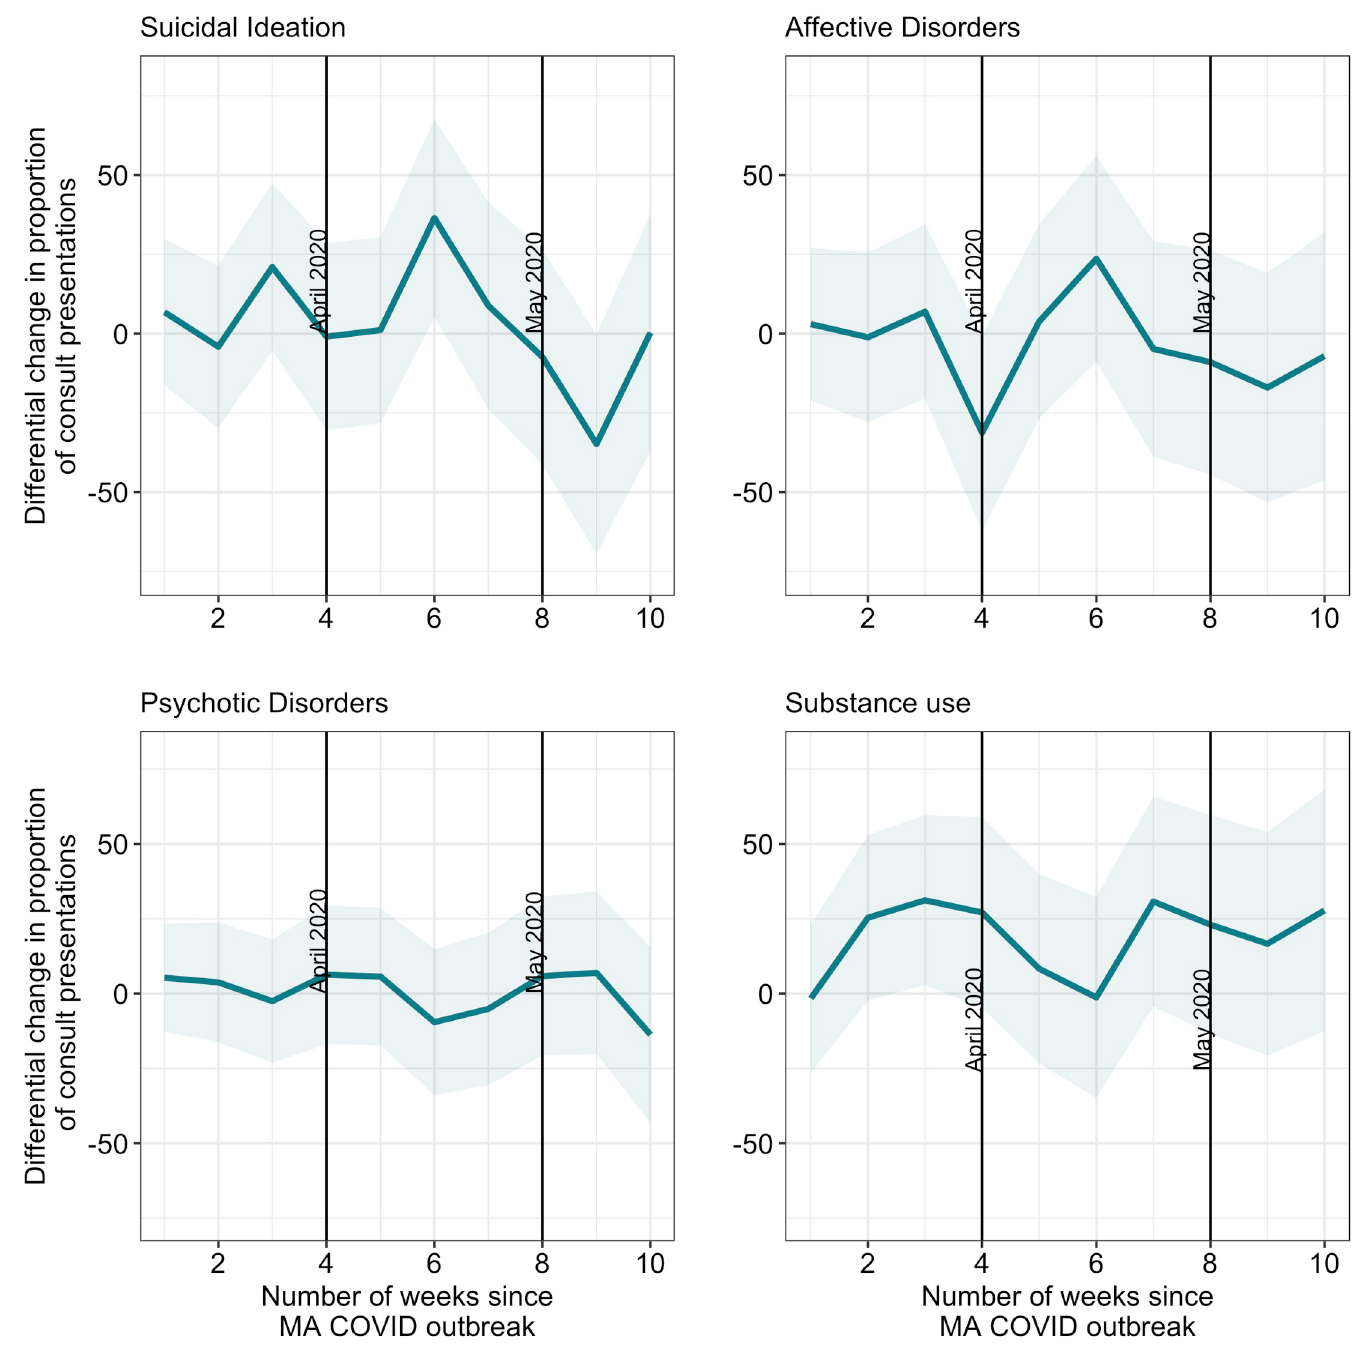
Fig 3. Differential changes in ED psychiatry consult presentations in the COVID versus non-COVID post